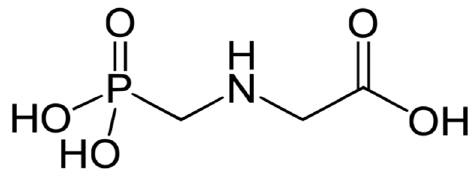
Figure 1. The chemical structure of glyphosate.